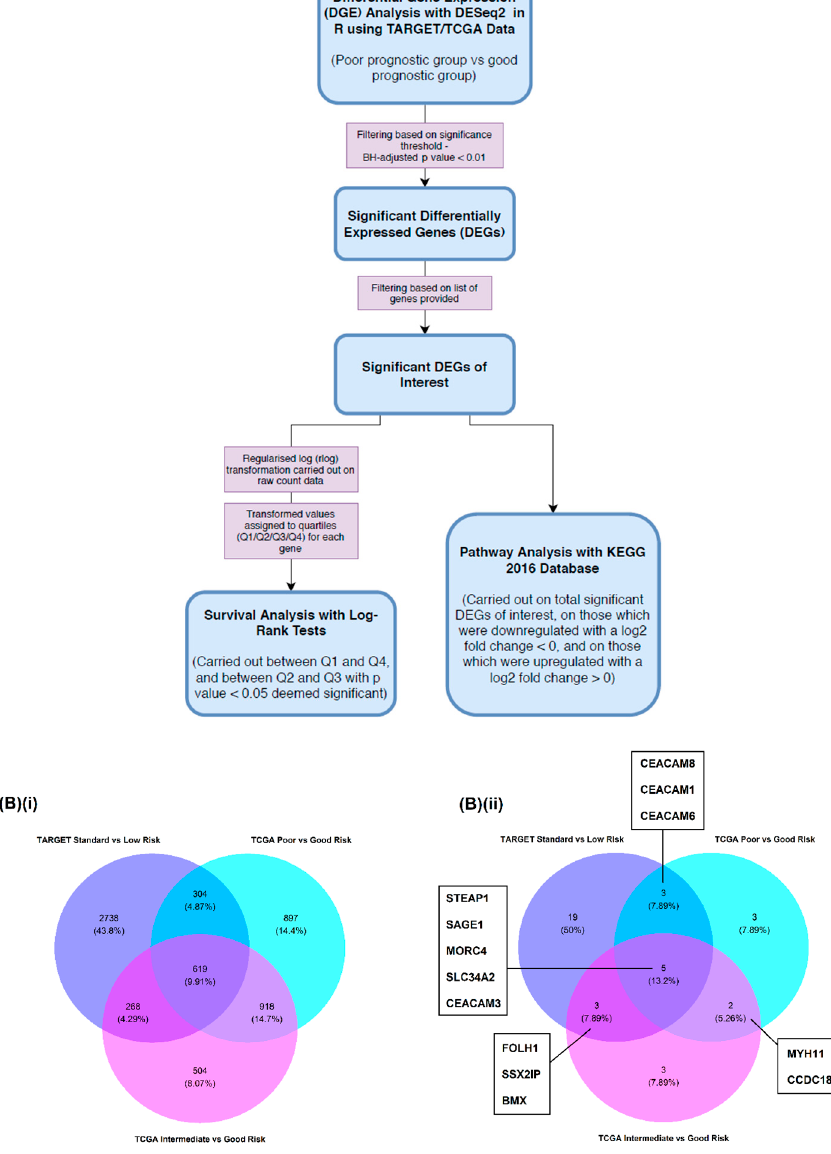
Figure 1. Overview of the analytical workflow and identification of differentially expressed genes (DEGs) that overlap between subgroup comparisons. ( A ) DESeq2 was used to perform differential gene expression (DGE) analysis using mRNA-Seq raw counts for various poor prognostic versus good prognostic group comparisons within Therapeutically Applicable Research to Generate Effective Treatments (TARGET), and The Cancer Genome Atlas (TCGA) patient datasets. DGE results were filtered (Benjamini–Hochberg (BH)-adjusted p value < 0.01) to yield significant DEGs. Where genes of interest (GOI) were found to be significantly differentially expressed, raw count data within a corresponding subgroup comparison was transformed and expression levels of GOI across all patients in the comparison were assigned to a quartile (Q1/Q2/Q3/Q4). Log-rank tests were carried out between patients of Q1 and Q4 expression, and of Q2 and Q3, with p value < 0.05 deemed significant. Pathway analysis was also carried out using the Kyoto Encyclopedia of Genes and Genomes (KEGG) 2016 Database on total significantly differentially expressed GOI, on those considered as downregulated (log2 fold change < 0), and those considered as upregulated (log2 fold change > 0); ( B ) Venn diagrams provide a visual summary of ( i ) all genes and ( ii ) GOI that were identified as significantly differentially expressed when comparing TARGET and TCGA subgroups.